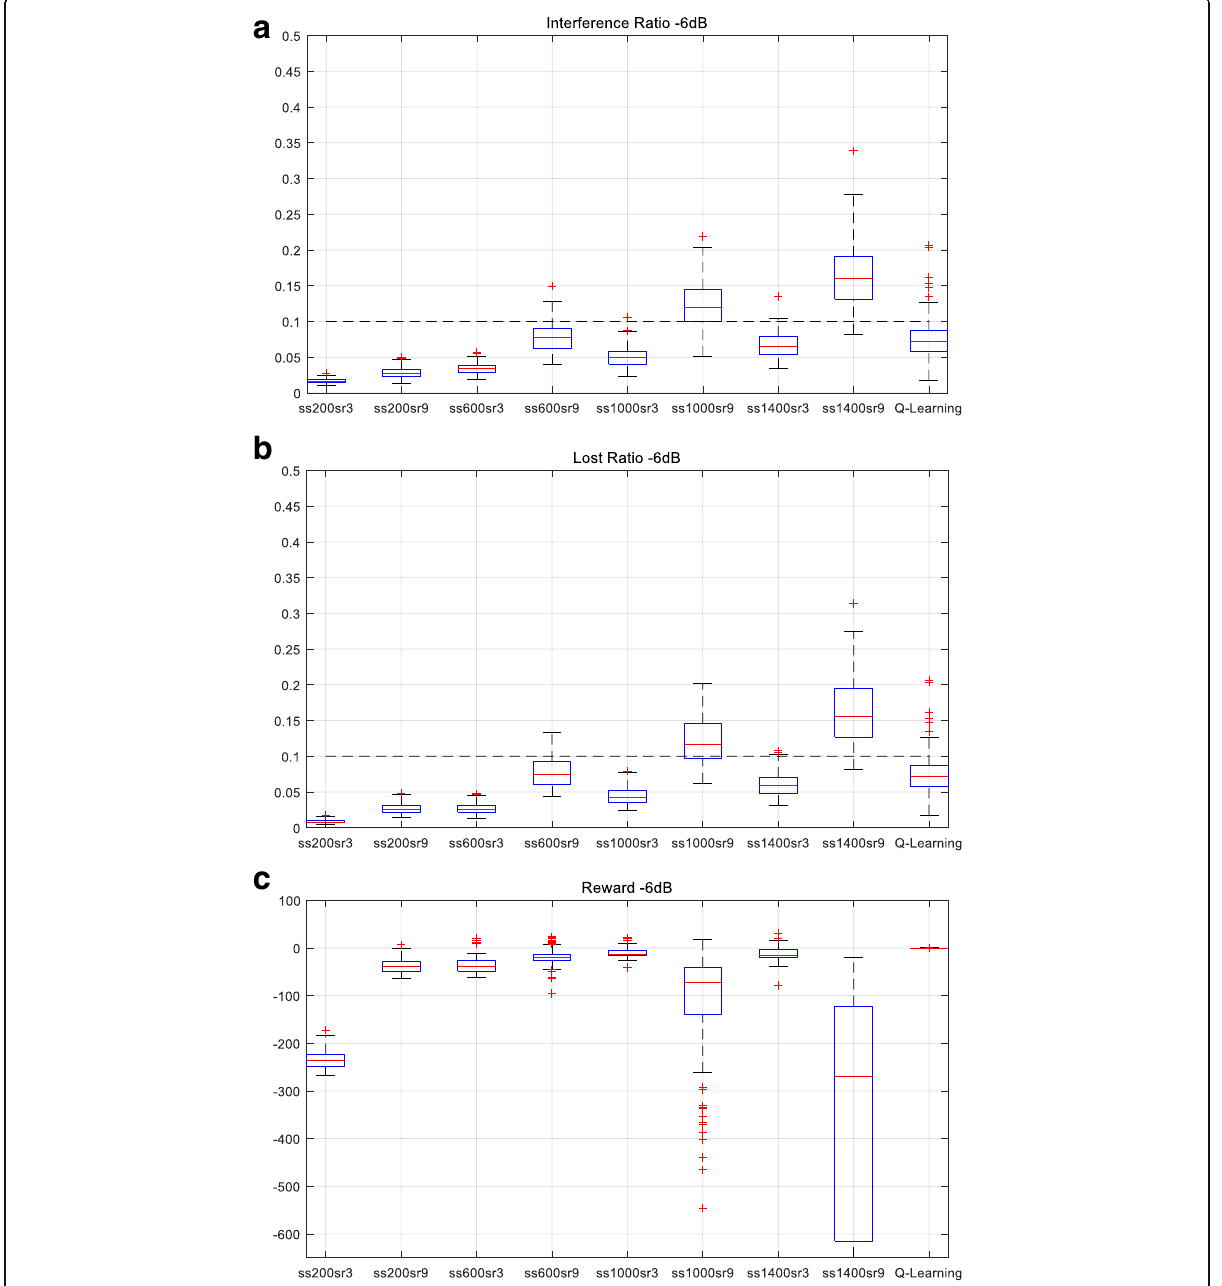
Fig. 12 Interference ratio, transmission opportunity loss ratio, and reward of the fixed case and Q-learning @ − 6 dB. a Interference radio. b Transmission opportunity loss ratio. c Reward. The performance of the interference ratio, transmission opportunity loss ratio, and reward is compared for cases where the sensing time, and the reply time are fixed and the proposed Q-learning is used for SNR of − 6 dB. In a representing the interference ratio and b representing the transmission loss ratio, the Q-learning operates within a stable range, but other cases for fixed sensing time and reply time also operate within a stable range. However, in c , which indicates reward, Q-learning shows overwhelming performance difference compared to other cases. Thus, it can be shown that the system load can be reduced by using